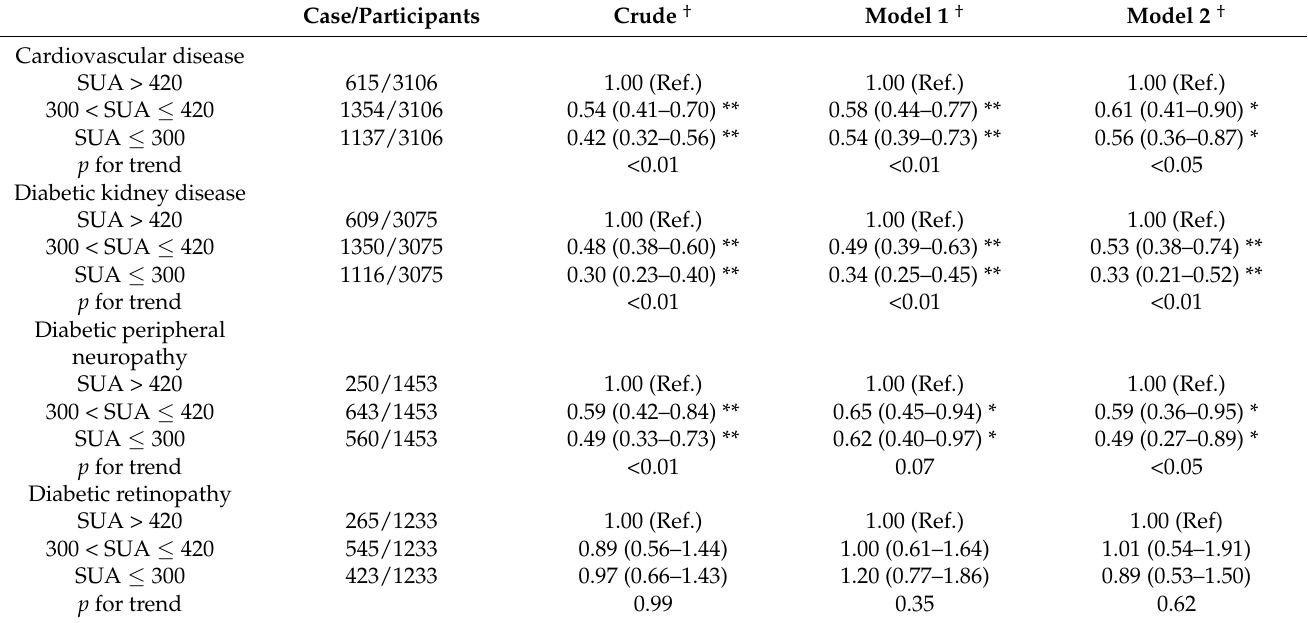
Table 3. Weighted odds ratios (95% confidence intervals) for chronic complication of people with diabetes across different levels of serum uric acid (SUA) ( n =